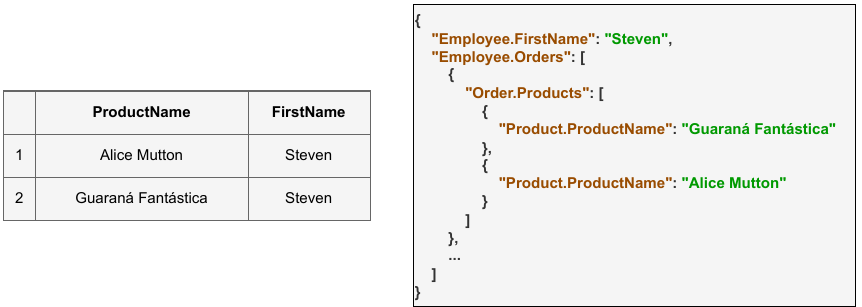
Figure 8. Query output for Q1. Left : Source database (Postgres). Right : Target database (Dgraph).